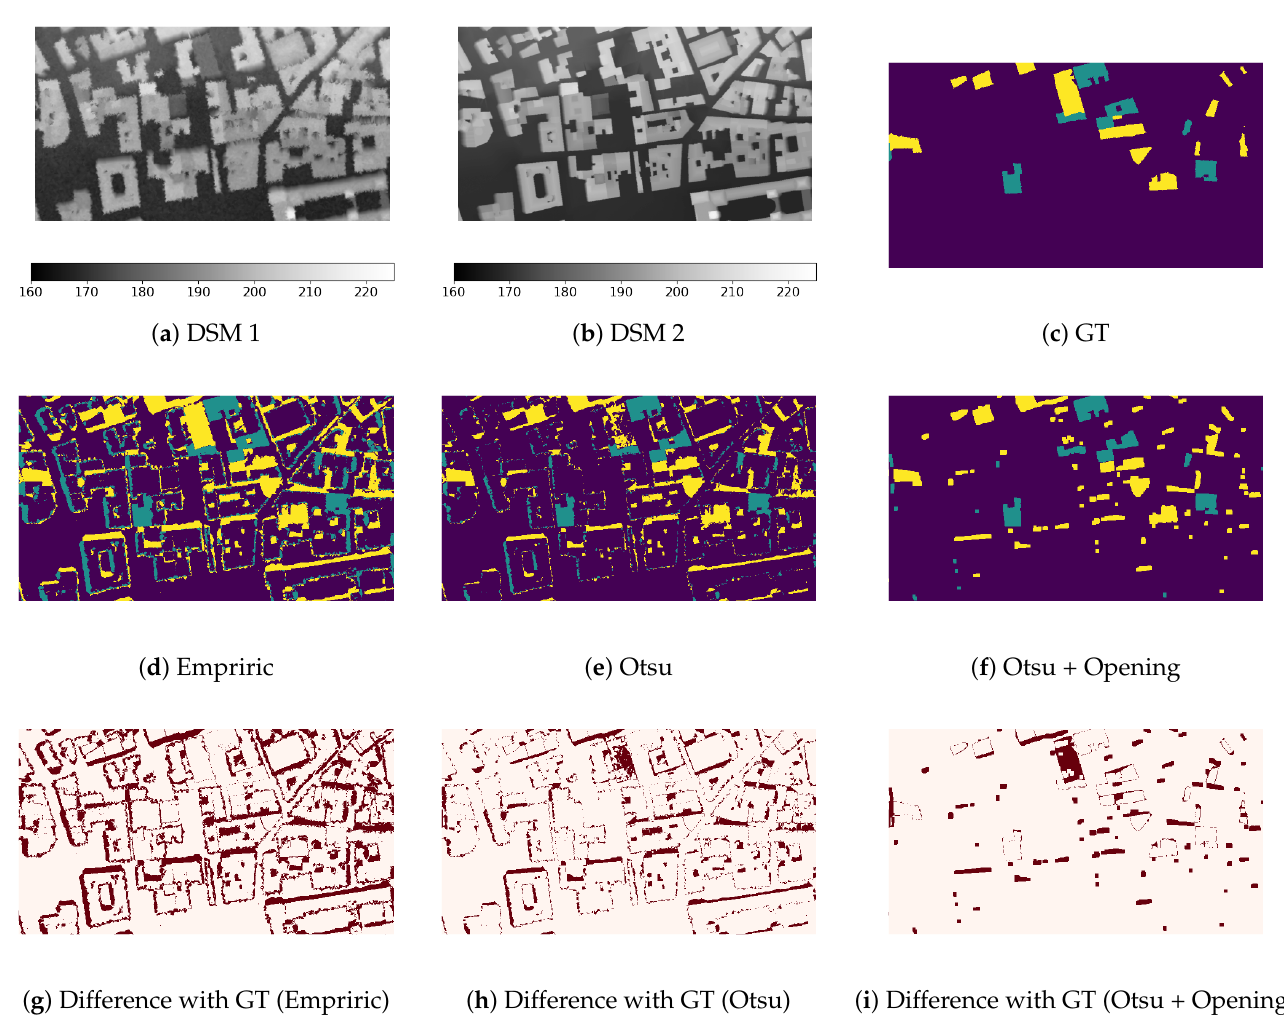
Figure 11. Results at the 2D pixel level for sub-dataset 5 (Multi-sensor). ( a , b ) DSMs with their elevation levels in meters and ( c ) ground truth (GT) with the following color code: purple for unchanged parts, blue for newly built parts and yellow for demolished parts. Results of DSMd with empirical thresholding ( d ), thresholds from the Otsu algorithm ( e ) and post-processing with an opening filter ( f ). Respective errors maps ( g – i ) highlight the differences (in red) from the ground